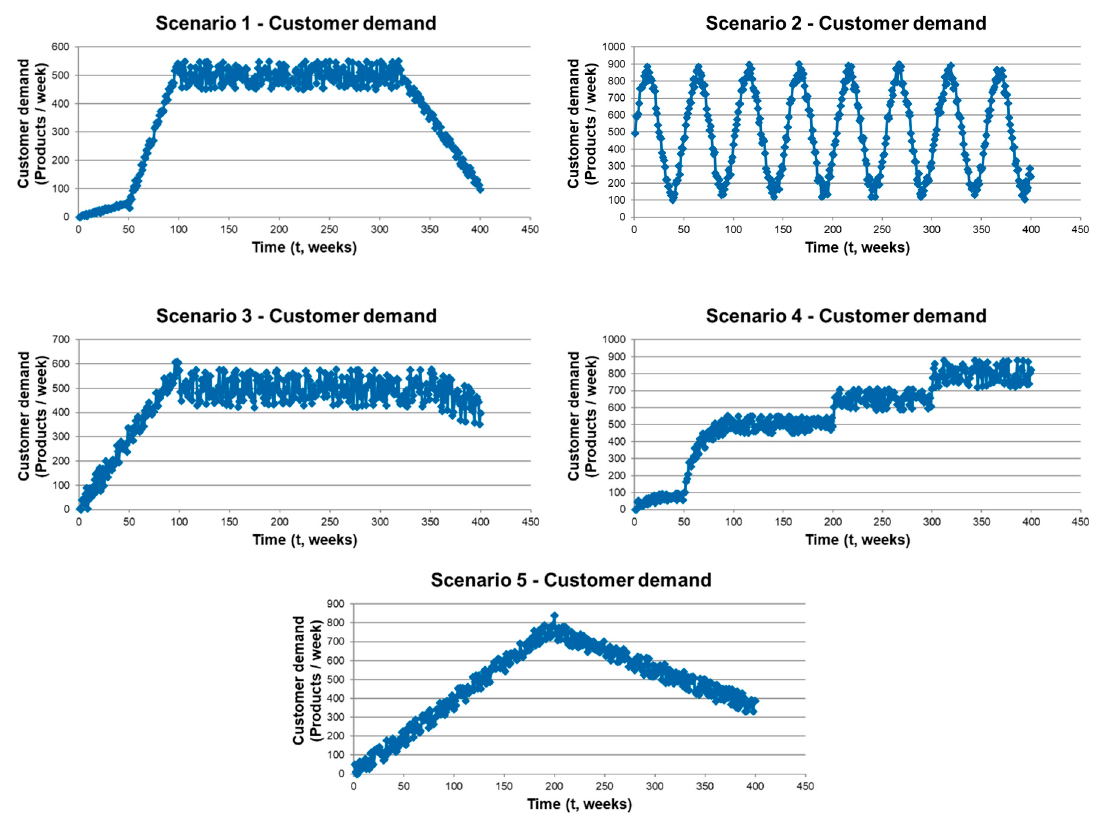
Figure 6. Generated demand scenarios based on lifecycle demand patterns (own elaboration).